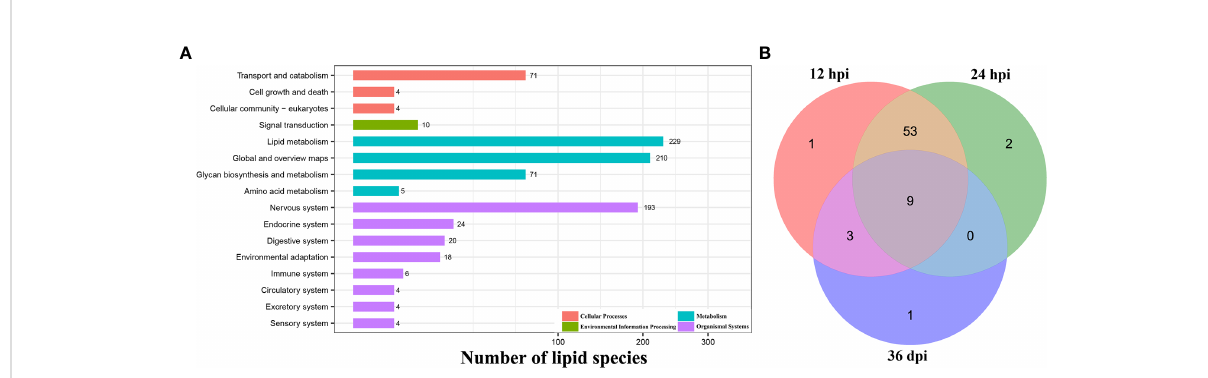
FIGURE 4 Functional enrichment analysis. (A) The KEGG pathway enrichment analysis of all identi fi ed lipid species at level 1 and level 2 classi fi cation. The X-axis represents the number of lipid species, and the Y-axis represents the KEGG pathway at level 2 classi fi cation. (B) Venn diagram shows the common and unique differential metabolic pathways among the three infection